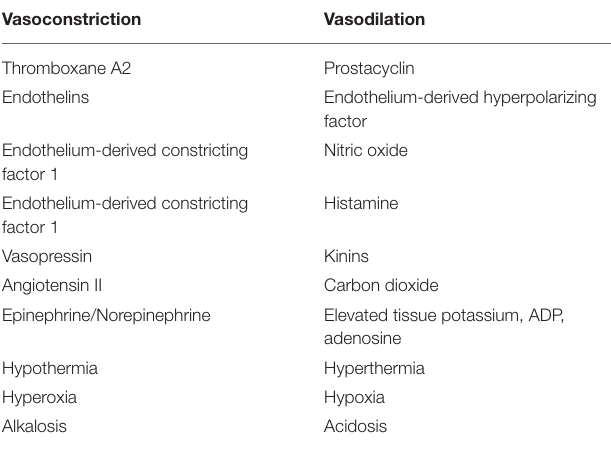
TABLE 1 | Endogenous chemical mediators of vascular smooth muscle tone.